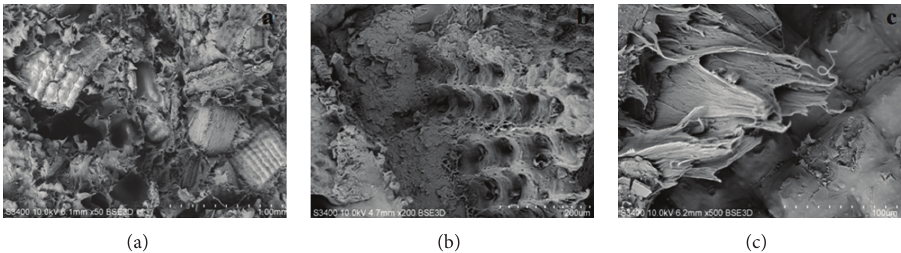
Figure 6: SEM micrograph of the surface on 20% RH loading contents composites: (a) 50x magnification, (b) 200x magnification, and (c) 500x